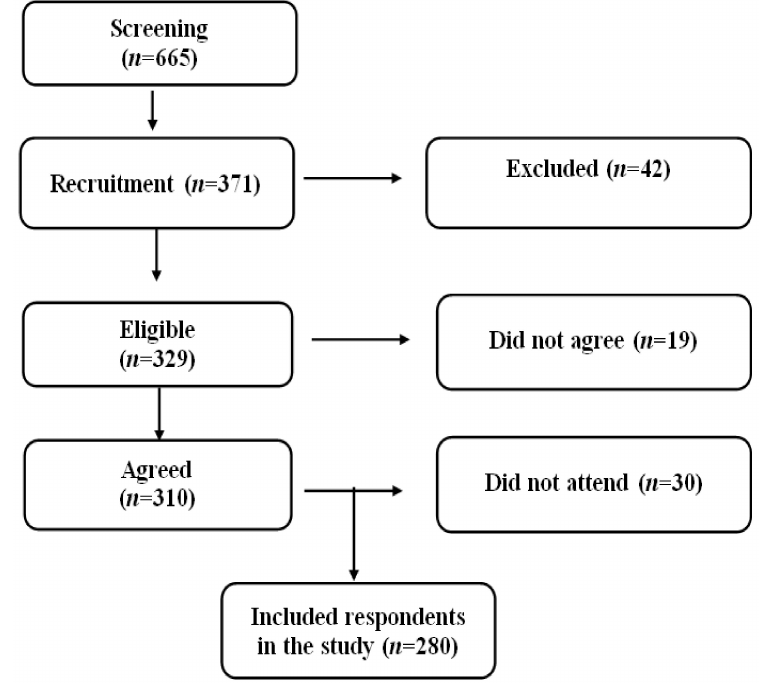
Figure 1. Screening and Recruitment of the Study